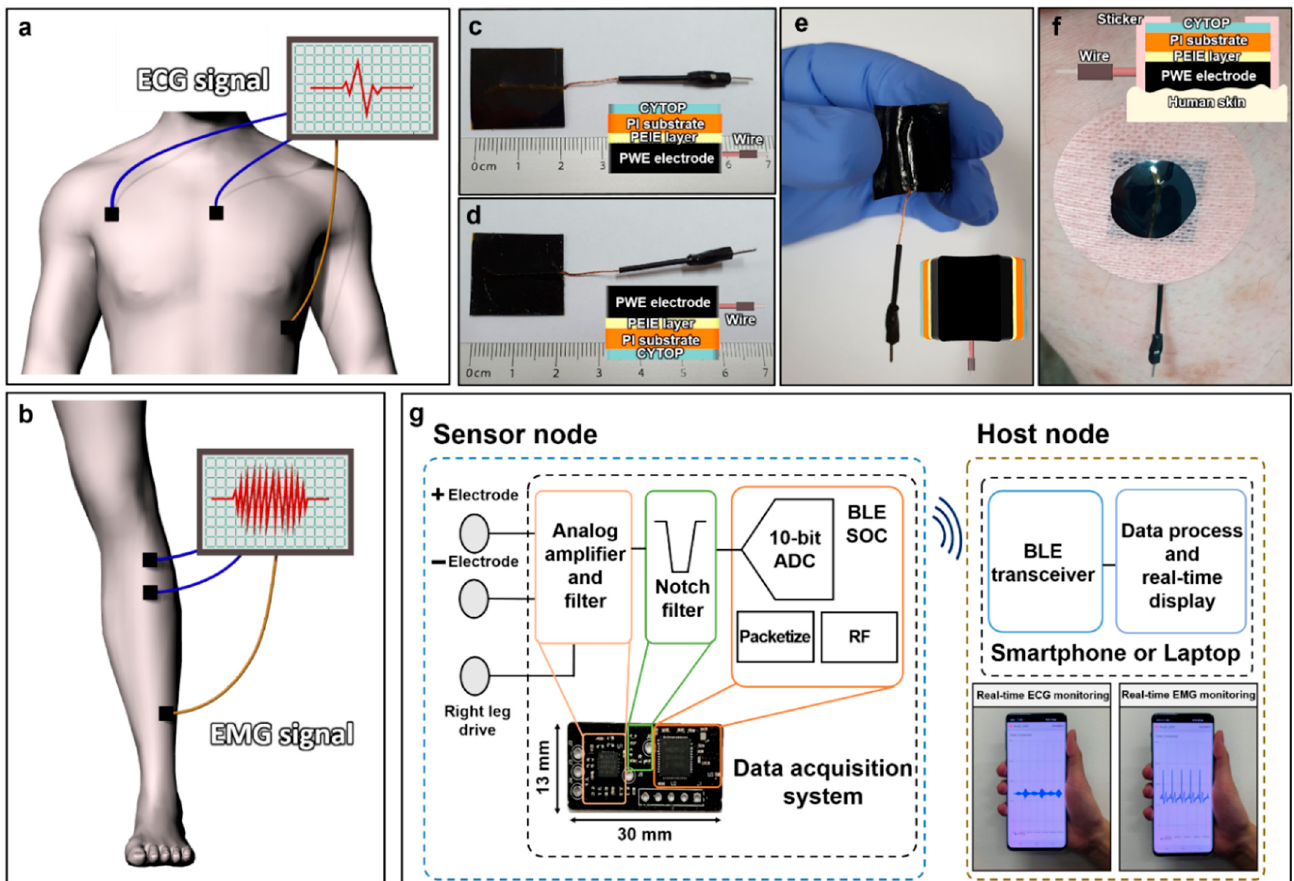
Figure 2. The ECG and EMG biopotential signal detecting system, and the wireless real-time monitoring system. The 3D illustration of 2-electrode systems and 3-electrode systems for detecting human ECG and EMG biopotential signals. Blue electrode: positive and negative electrodes, yellow electrode: reference electrode. ( a ) The position of WPD electrodes attached to a human chest to detect the ECG biopotential signals; ( b ) the position of WPD electrodes attached to a human right leg to detect the EMG biopotential signals; the photography of the fabricated WPD electrodes; ( c ) the front side of the WPD electrodes; ( d ) the back side of the WPD electrodes; ( e ) the flexibility of the WPD electrodes; ( f ) the WPD electrodes attached to a real human body; ( g ) the block diagram of a real-time monitoring system.